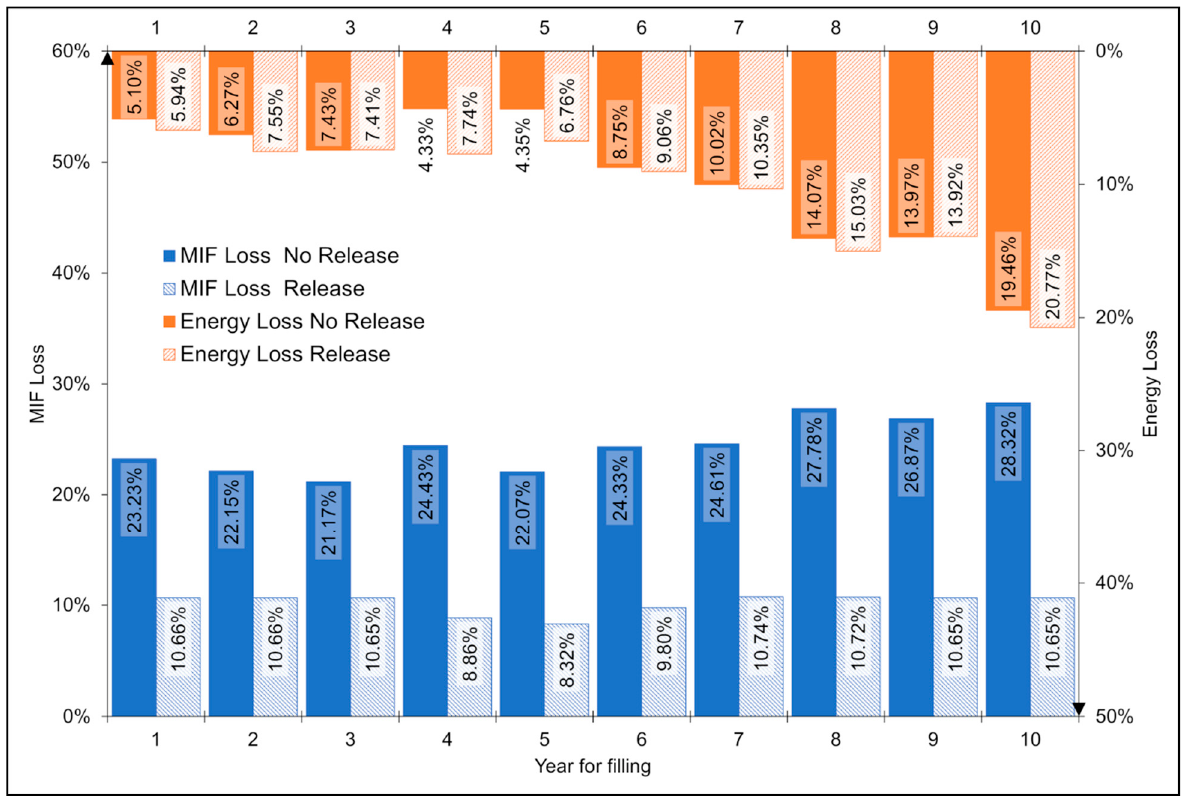
Figure 5. MIF loss, and energy loss for the GERD dam, depending upon of different duration of the filling period, from 1 to 10 years. Simulation during 2010–2019.